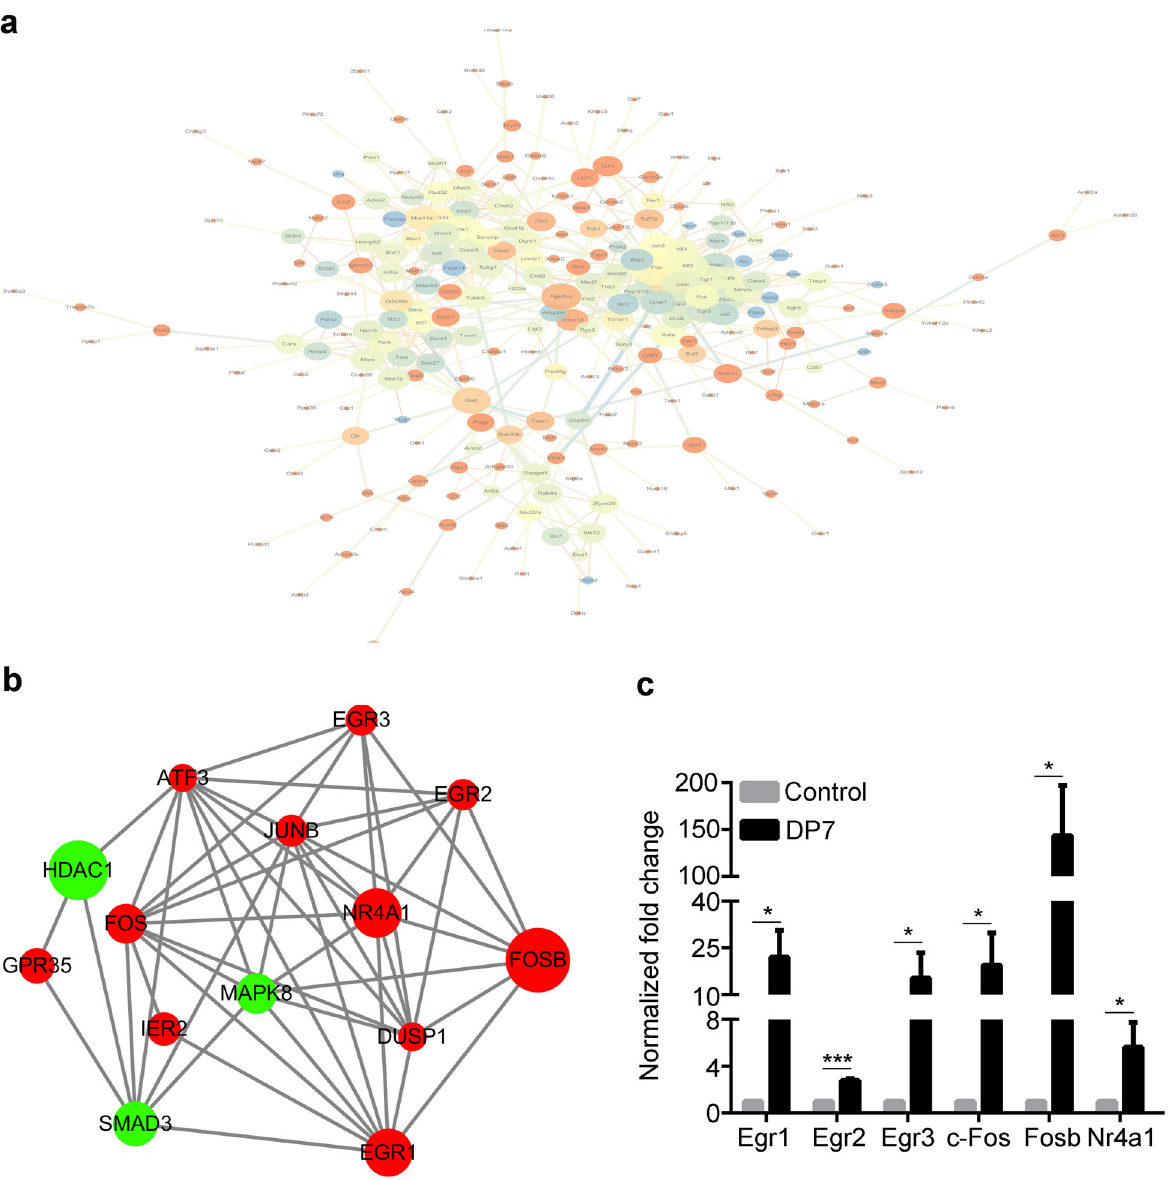
Fig. 5 Signaling pathways involved in peptide DP7 activity in BMDCs. a An Egr1-centered protein – protein association network of the 117 genes, as analyzed by STRING. b An Egr1-centered protein-protein association network of 6 genes involved in the Egr1-centered network. c JAWSII cells were stimulated with DP7 (40 μ g/ml) for 30 min and then harvested for RT-qPCR analysis. The control indicates the nonstimulated group. Data are representative of three experiments with three replicates each. Statistical analyses were done using the t-test. Bars represent means and SEM. * P < 0.05, *** P <